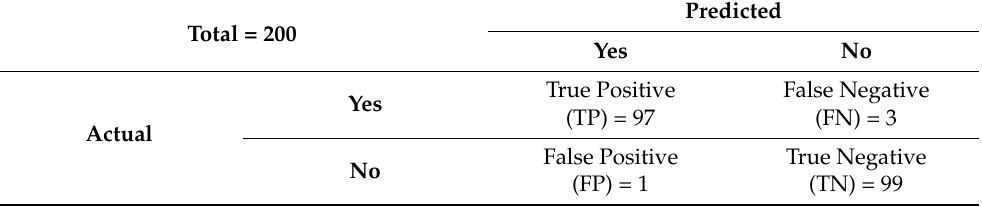
Table 10. Results for